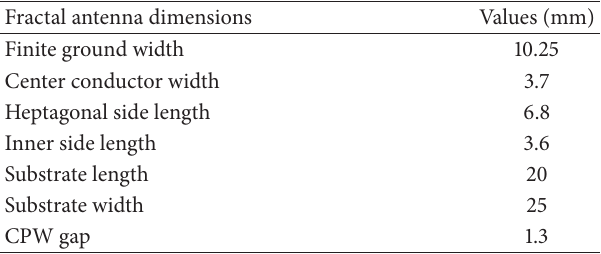
Table 1: Fractal antenna